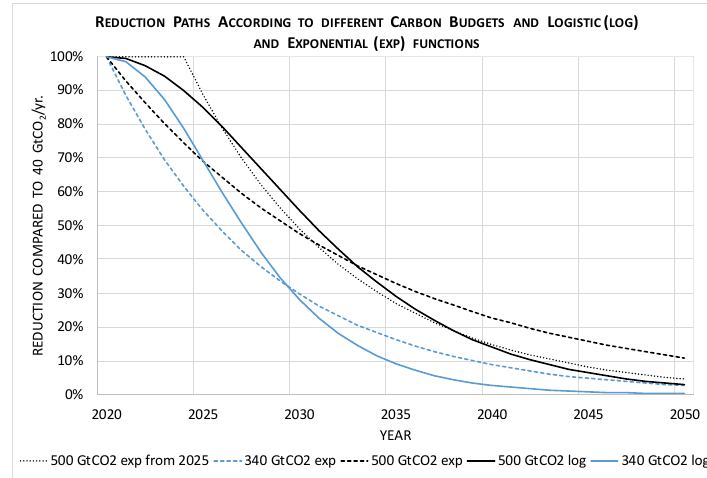
Figure 2. CO 2 reduction pathways between 2020 and 2050, limiting the CO 2 budget to 340 (500) GtCO 2 until 2050 along exponential and logistic curves [10].